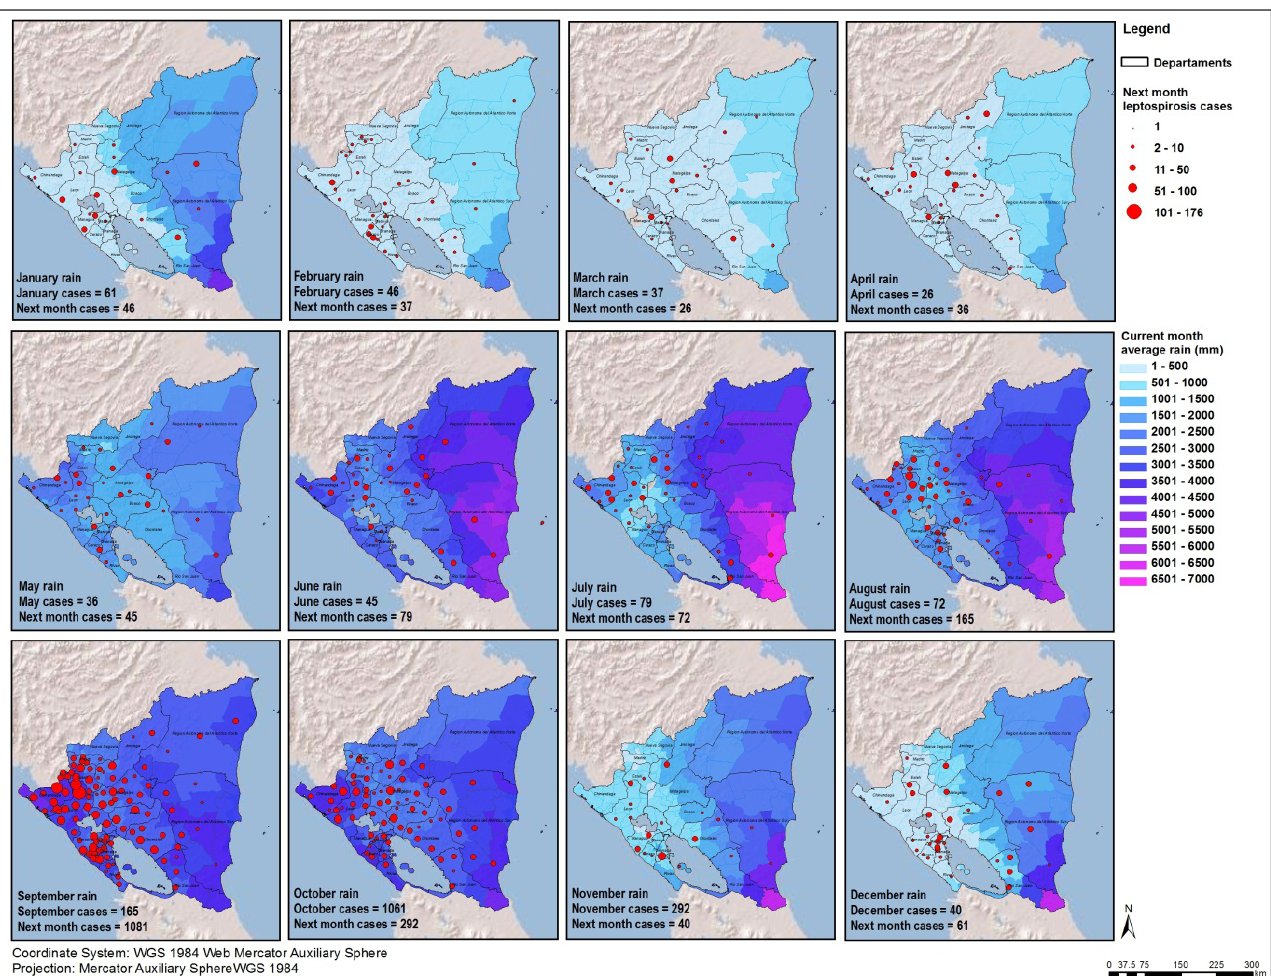
Figure 5. Average rainfall and total number of cases of leptospirosis, in the next month, by municipality Nicaragua,